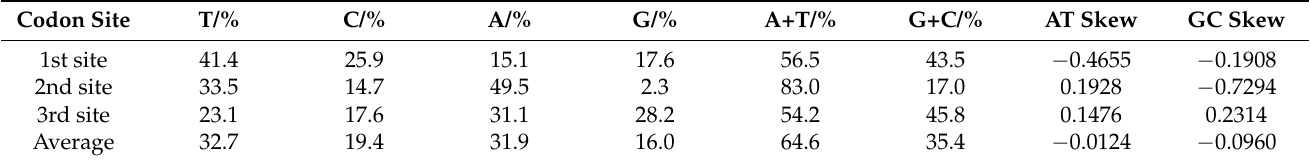
Table 2. Nucleotide composition of DNA barcode sequences from the 30 specimens collected in this study.